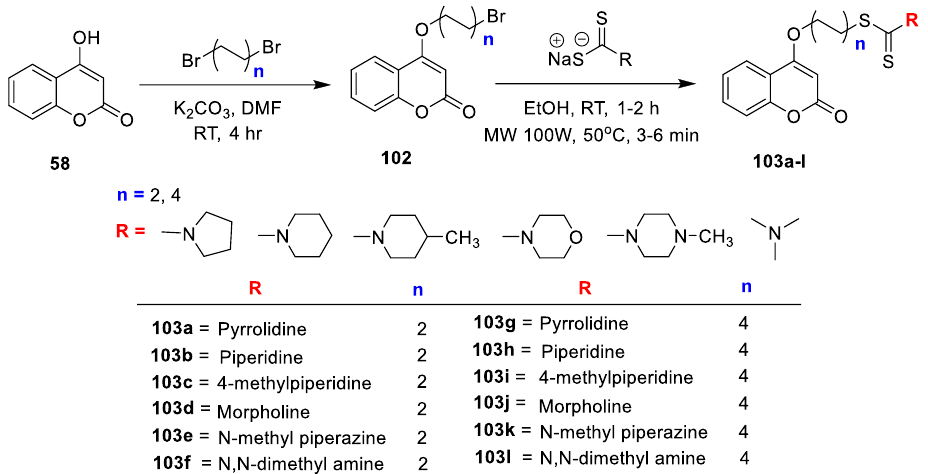
Scheme 18. Design of coumarin bearing dithiocarbamate 103a–l . Reproduced and adapted with permission from Ref. [34]. Copyright 2018, Elsevier.